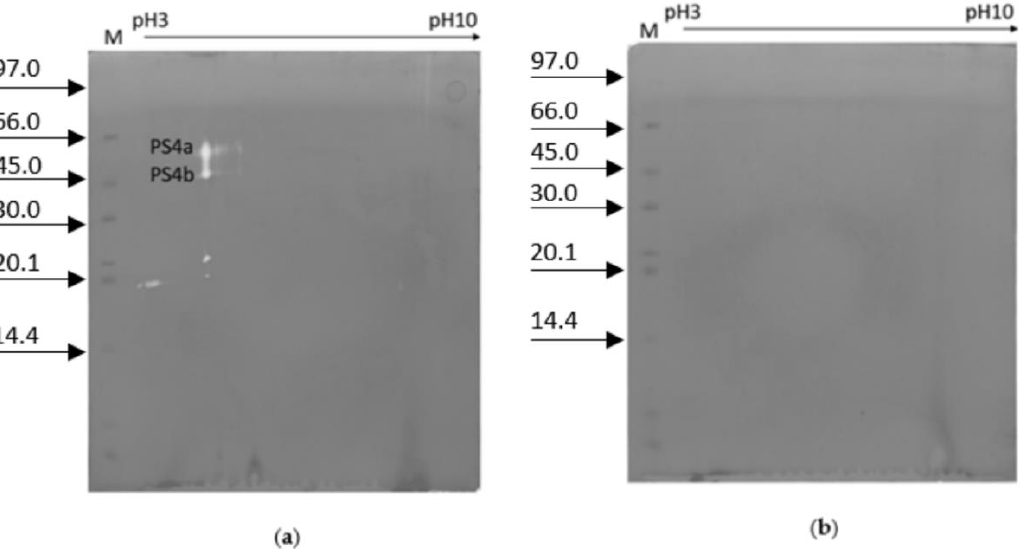
Figure 6. 2D zymography of 5th-instar worker-fate larvae crude extract: ( a ) with gut; ( b ) without gut. Strip 11 cm, pH 3–10, T 15%, C 2.6%. M = marker low range in kDa.